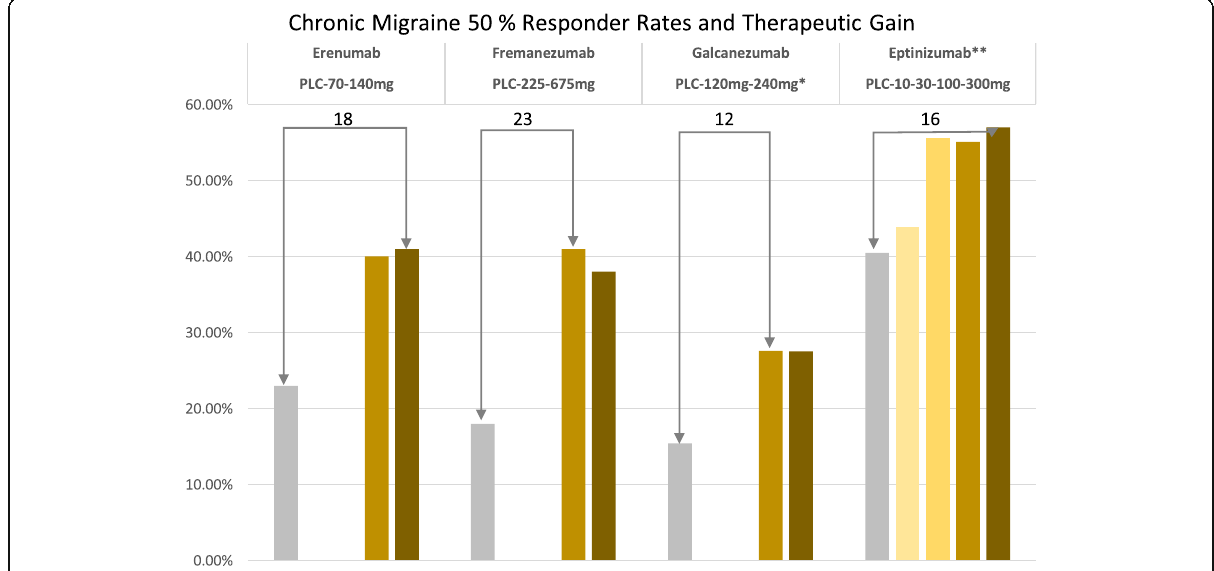
Fig. 2 50% responder rates for the prevention of chronic migraine. The numbers on top of the columns reflect therapeutic gain (verum minis